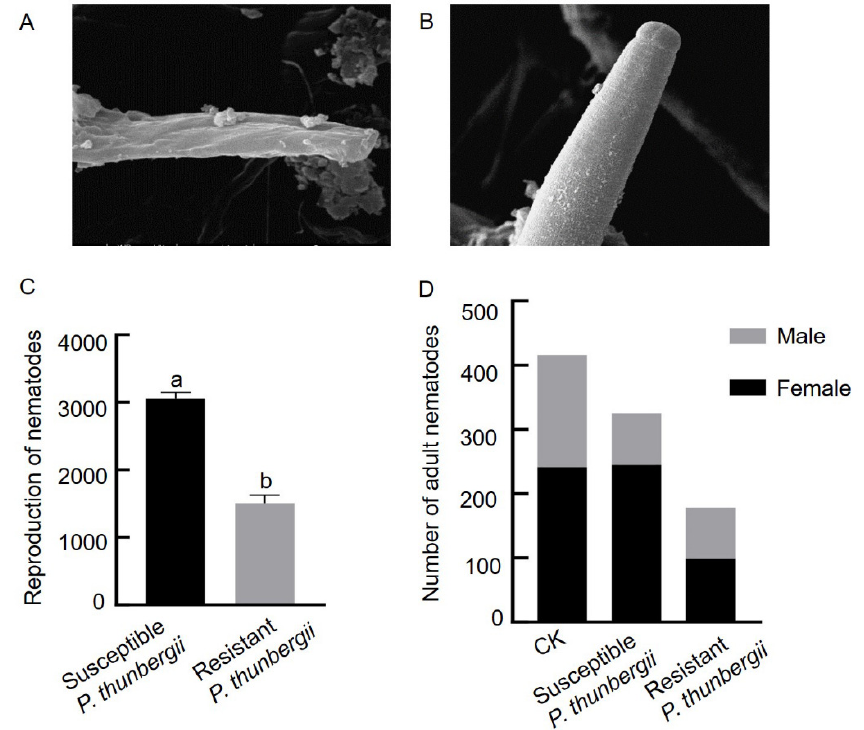
Figure 2. Differences in morphology, population size and sex ratio of PWNs in P. thunbergii with different levels of resistance. ( A ) Head of PWNs in resistant P. thunbergii. ( B ) Head of PWNs in susceptible P. thunbergii. ( C ) Population size of PWNs in P. thunbergii with different levels of resistance. ( D ) Number of female and male PWNs in P. thunbergii with different levels of resistance. The different letters above the error bars indicate statistically significant differences ( p < 0.05) as measured by Duncan’s multiple range test. CK: PWN before